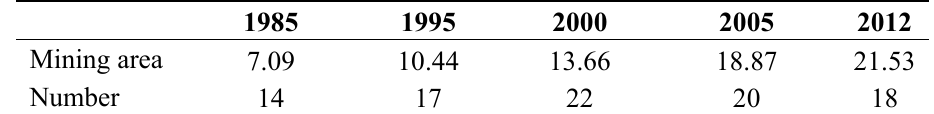
Table 2. Mining area and number changes in Suxian district from 1985 to 2012 (km 2 ).